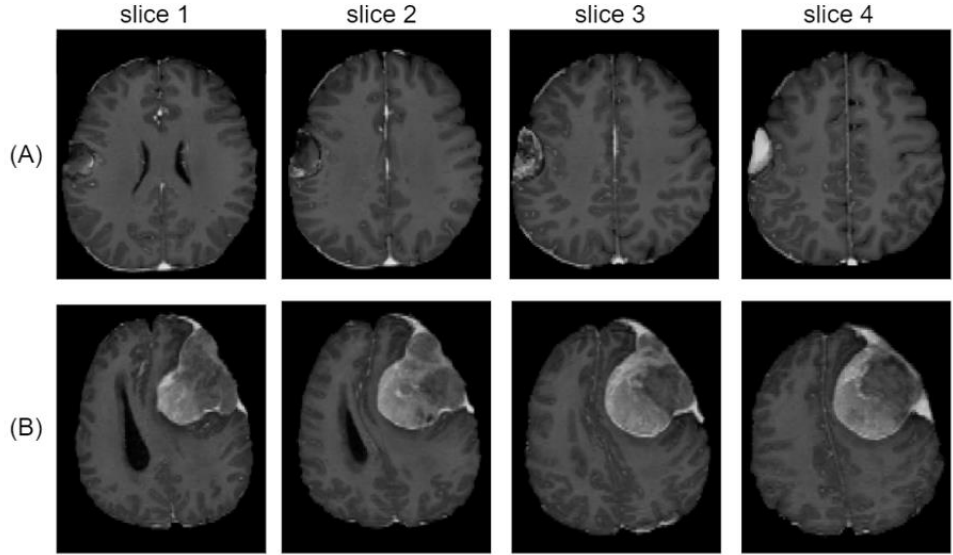
Figure 2. Meningioma lesion from two representative patients in the test set. ( A , B ) are brain slices showing heterogeneous enhancement inside the tumor (15 mm spaced slices).